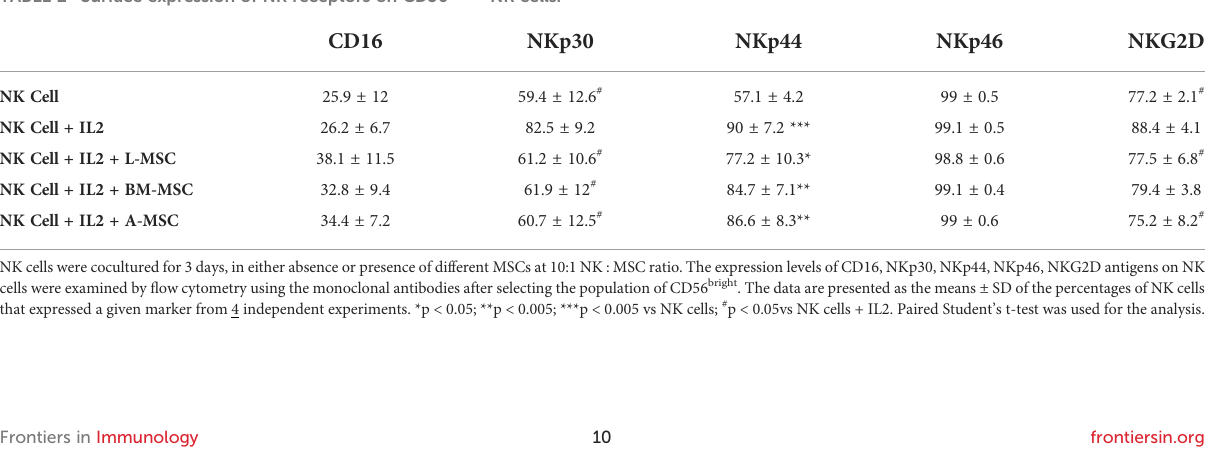
TABLE 2 Surface expression of NK receptors on CD56 bright NK